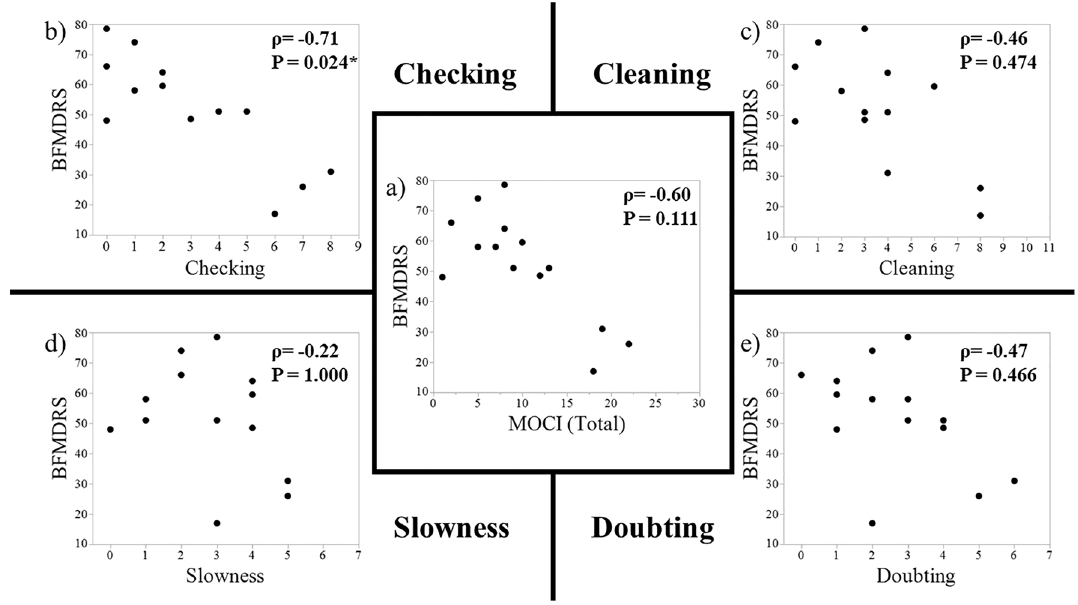
Figure 1. Correlations between the BFMDRS and the total MOCI score ( a ) and the scores of the four MOCI subscales ( b – e ). The correlation coefficient (ρ) and corresponding p values ( p ) are shown. A p value < 0.05 is statistically significant. BFMDRS, Burke–Fahn–Marsden Dystonia Rating Scale; MOCI, Maudsley Obsessional Compulsive Inventory.